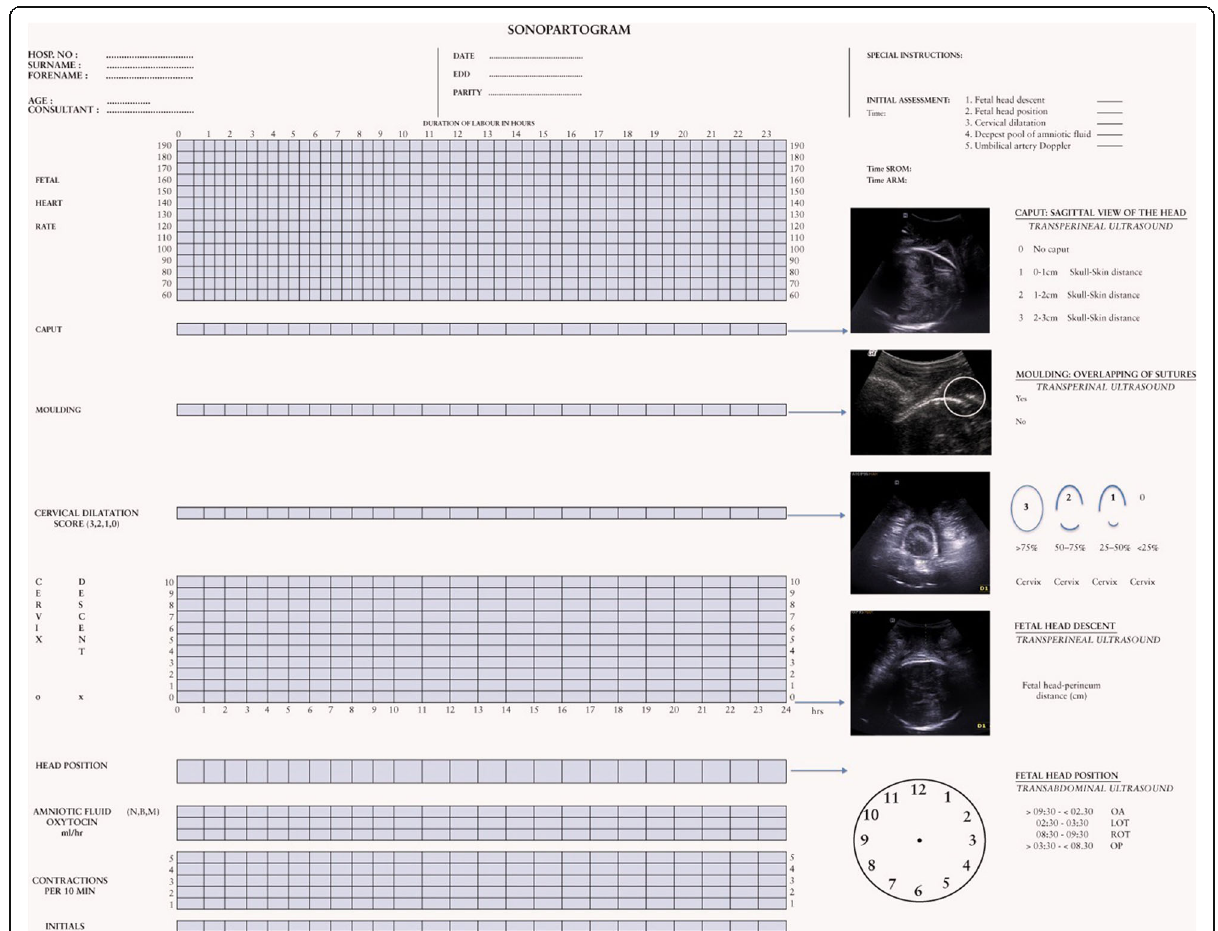
Fig. 8 Sonopartogram. A sample sonopartogram showing fetal head descent, cervical dilatation, and head rotation with explanatory ultrasound images and depiction of the cervical dilatation score